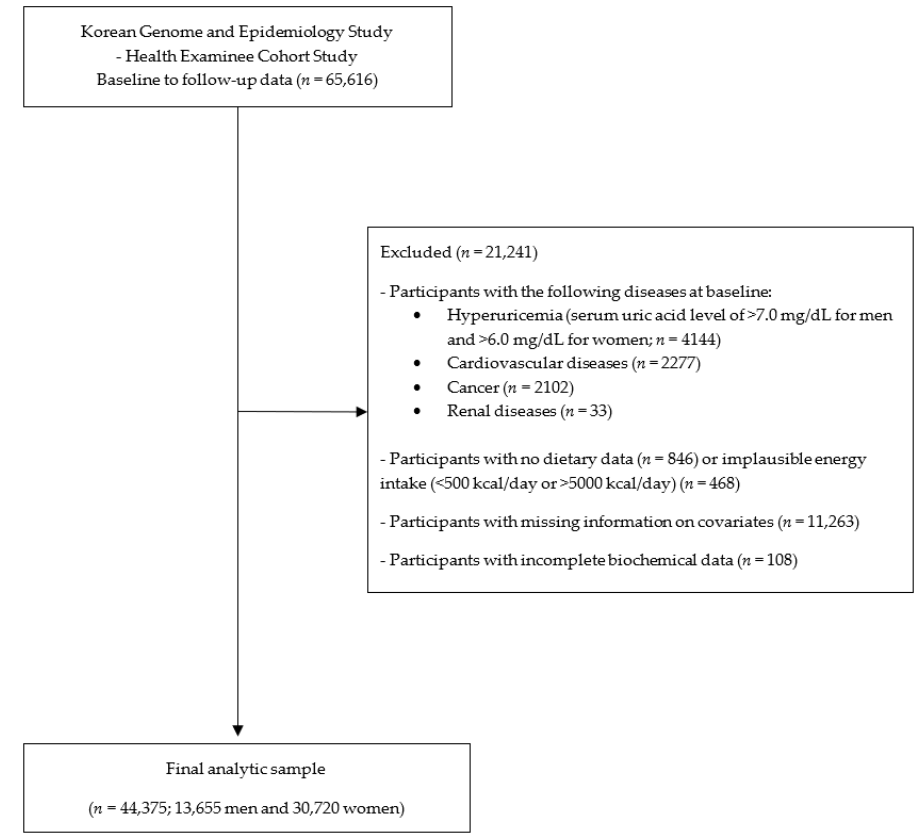
Figure 1. Flowchart of the study population.